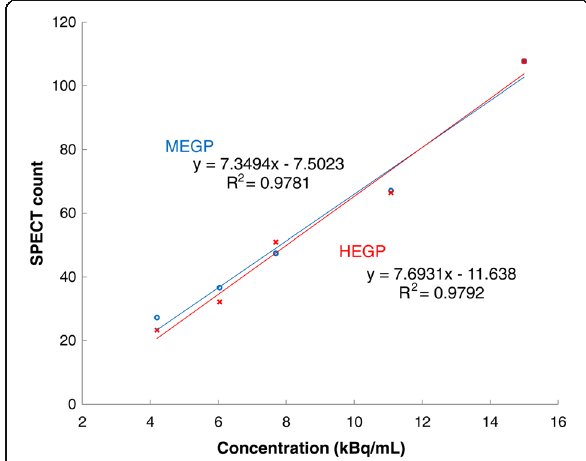
Fig. 4 Relationship between radio-concentration of Ra-223 and SPECT counts at 84 keV ± 20% when using the MEGP or HEGP collimators. MEGP medium-energy general purpose, HEGP